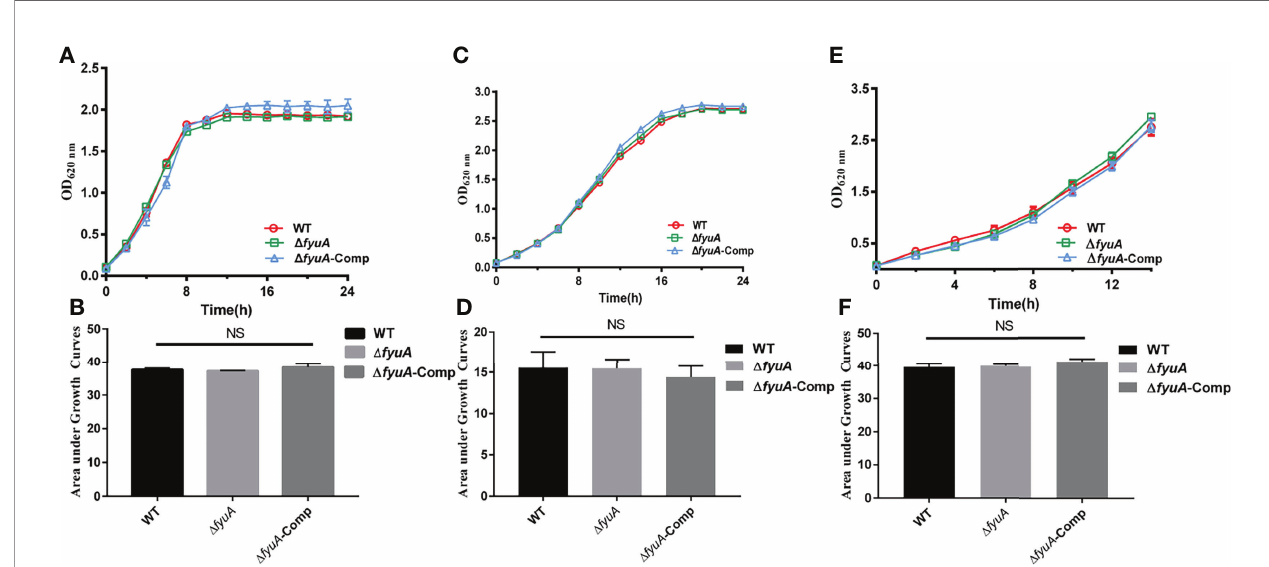
FIGURE 1 | Growth curves of Y. pestis . Growth curve of WT, D fyuA , and D fyuA -Comp at 37°C in LB (A) , at 26°C in de fi ned TMH with 0.1 mM FeSO 4 (C) , or at 26°C in deferrated TMH with 10 m M FeCl 3 (E) . The bacterial growth was monitored by measuring the absorbance at OD 620 nm at 2 h intervals. The areas under the growth curve were applied for the statistical analysis of different conditions (B, D, F)